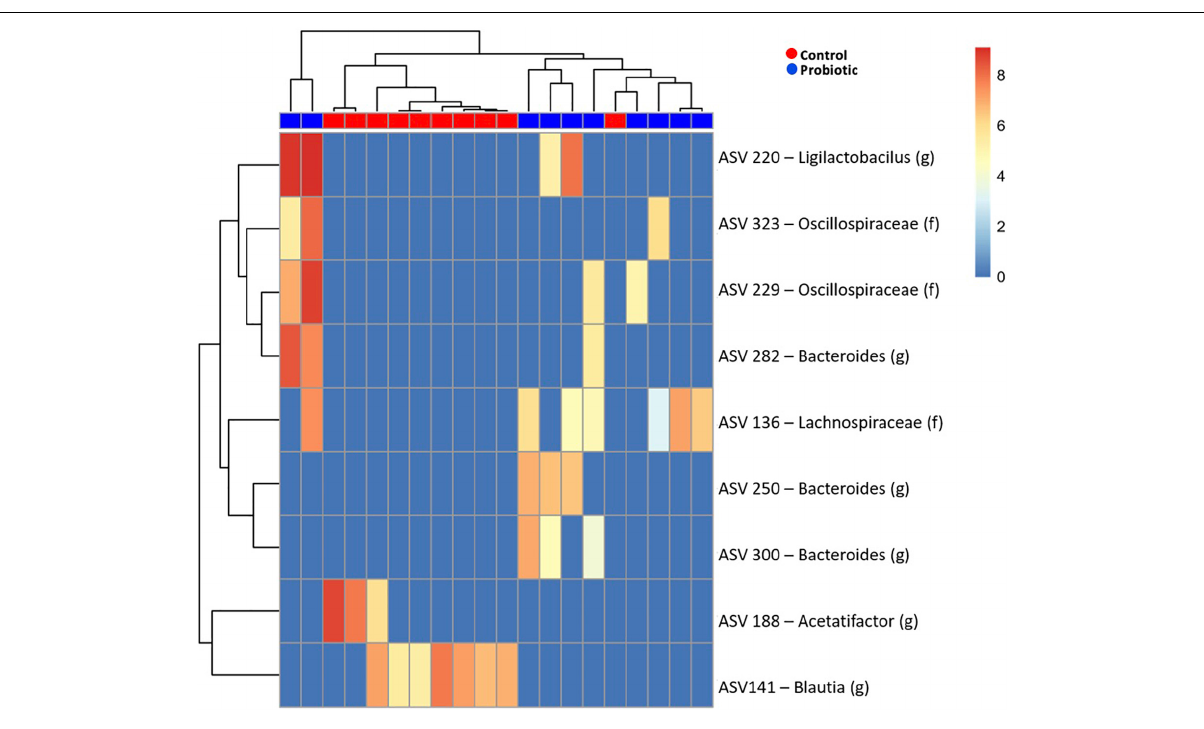
FIGURE 6 | Enriched amplicon sequence variants (ASVs) in the faeces of 3xTg-AD mice. Heatmap of differential abundance of significant ( p > 0.01) ASVs in 3xTg-AD mice when comparing the Control and Probiotic groups using DESeq2 normalisation for data after logarithmic transformation, displaying enrichment of